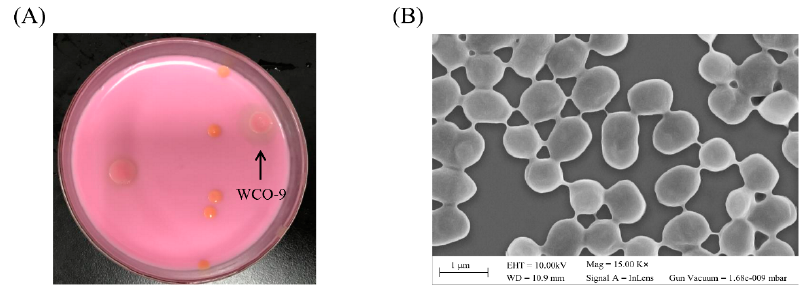
Figure 1. Colony and cell morphology of strain WCO-9: ( A ) colony morphology of strain WCO-9 grown on the oil assimilation plate containing rhodamine B for 24 h at 30 °C; ( B ) scanning electron microscopy (SEM) showing the morphology of strain WCO-9. Bar: 1 μ m.